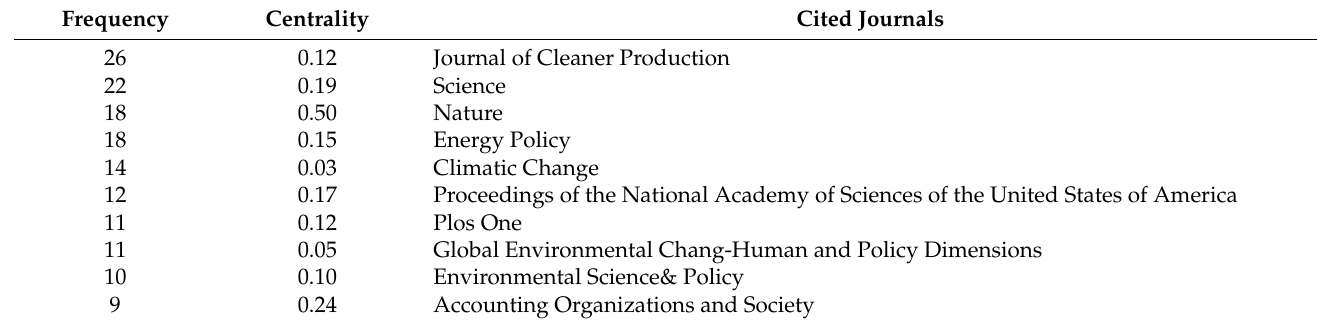
Table 5. Top 10 most-cited journals.